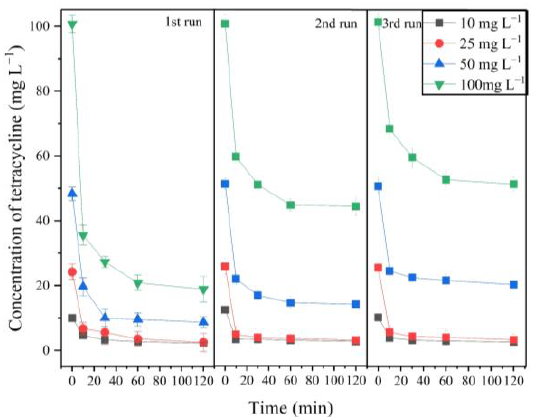
Figure 3. Effect of H 2 O 2 and TC supplementation on degradation of TC by the MnP system. The transformation kinetics of TC by MnP can satisfactorily be described by the Mich- aelis – Menten model (Figure S6). The kinetic constants, v max and K m , were 20.35 mg L −1 min −1 and 238.23 mg L −1 , respectively, based on non-linear regression analysis (Equation (S2)).